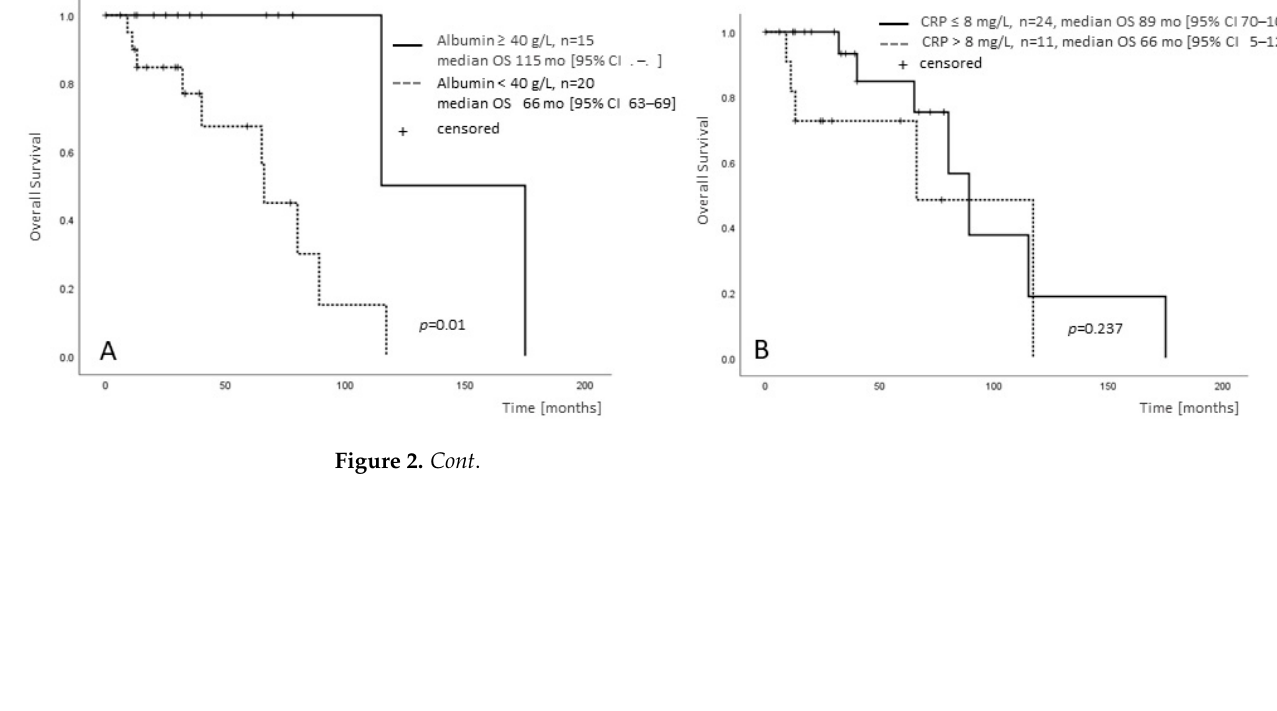
Figure 2. Albumin and CRP provide MIPSS70-independent prognostic information in MF. Survival of MIPSS70-intermediate-risk patients, for whom both albumin and CRP were available (n = 35), stratified by albumin </ ≥ 40 g/L ( A ), CRP ≤ /> 8 mg/L ( B ), CRP/albumin ratio ≤ /> 0.374 ( C ) and GPS </> 0 ( D ).